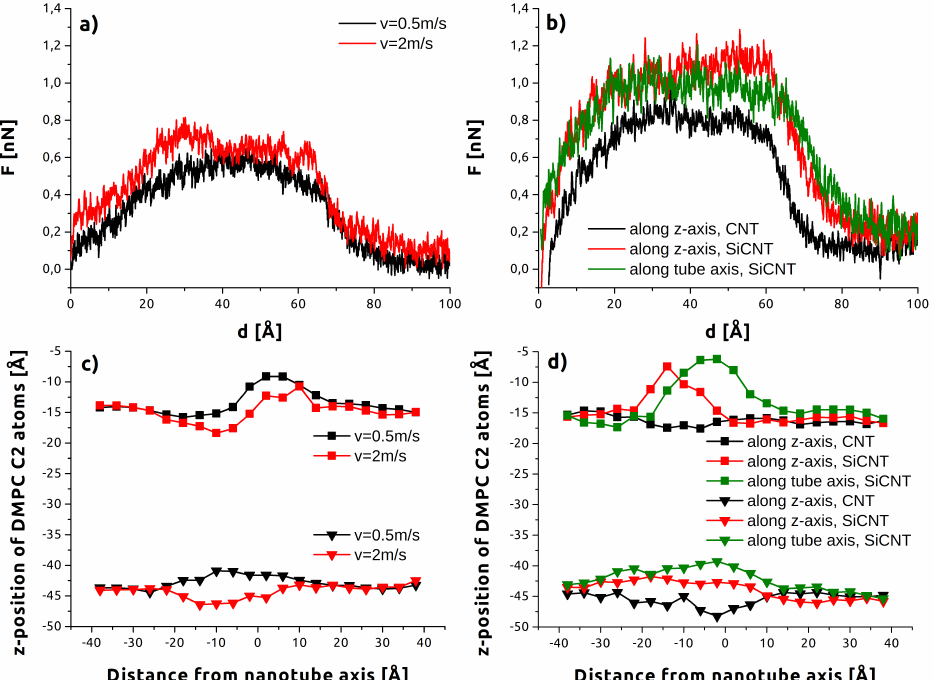
Figure 7. SMD forces vs. depth (top row) and backbone C2 atom positions along x -axis at indenter depth d = − 25 Å (bottom): selected comparisons. All cases simulated were angled at 15 ◦ . For the C2 atom profiles, both membrane layers are shown. Panels ( a , c ): rate comparison (CNT, tube-axis indentation). Panels ( b , d ): nanotube comparison (CNT/SiCNT high rate